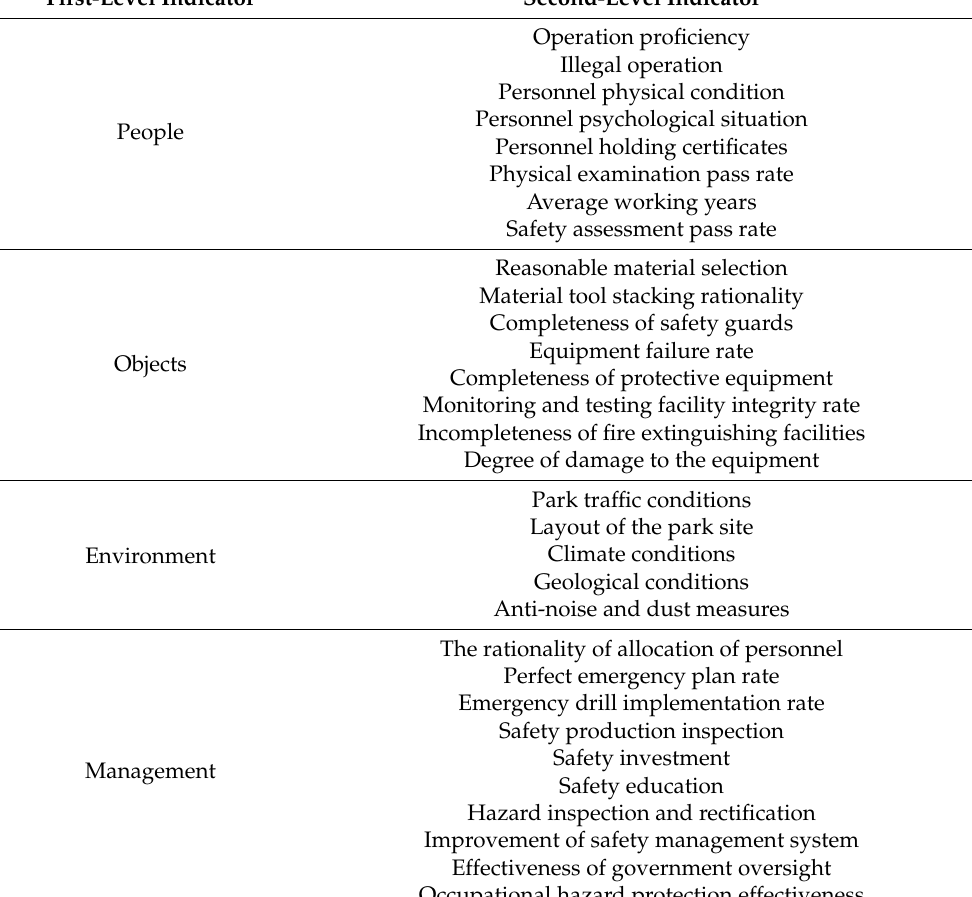
Table 1. Factors affecting the safety of island petrochemical parks.